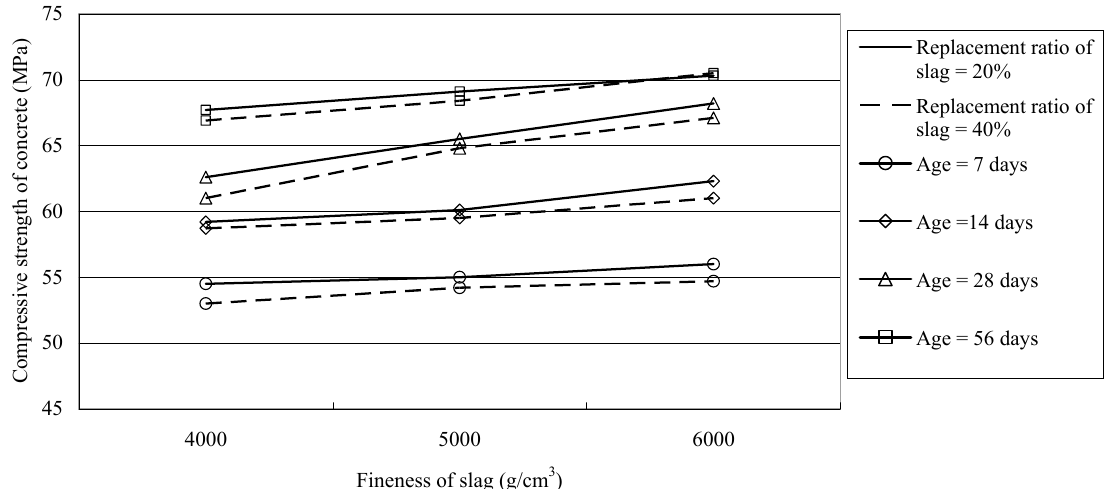
Figure 4. The average compressive strength of slag concrete versus the fineness of ground granulated blast furnace slag (GGBS).